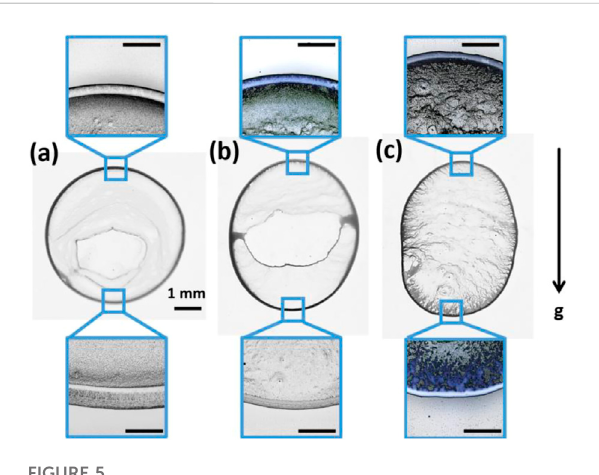
FIGURE 5 Depositpatternsleftbehindthedryingof0.1%w/wmicrospheres drops at (A) 0 ° , (B) 20 ° , and (C) 40 ° inclinations. Insets show a magni fi cation of the deposit patterns at the top and bottom of each case. The scale bar for all insets corresponds to 500 μ